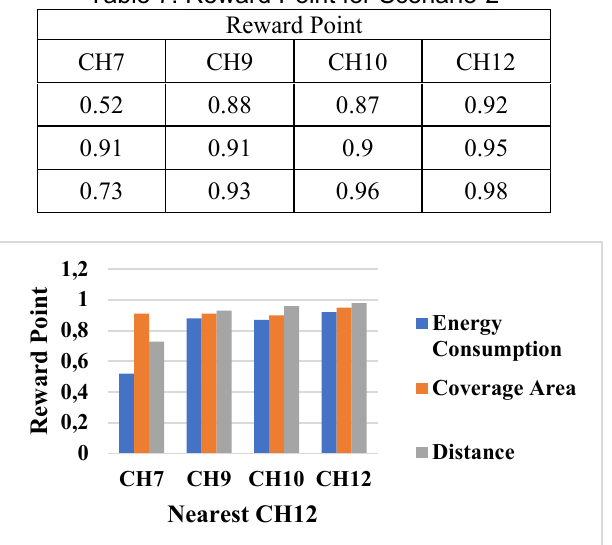
Table 7. Reward Point for Scenario-2